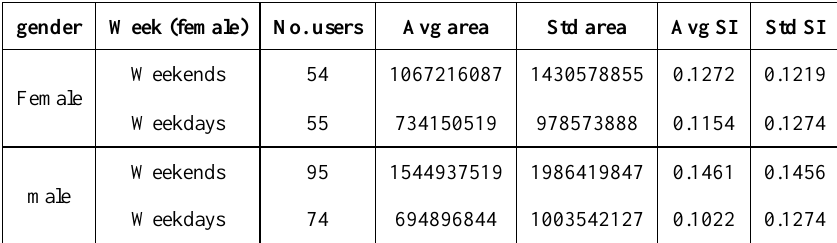
Table 3. Average and standard deviation of area and shape index of user's activity space grouped by days of the week